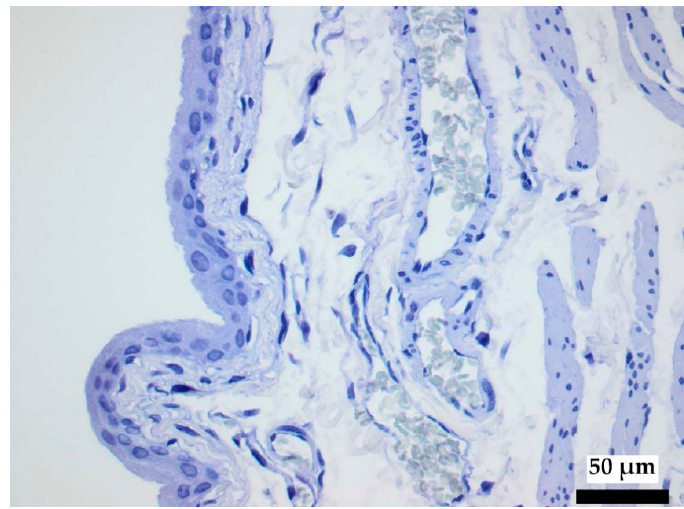
Figure 6. Rhodanine staining of urinary bladder tissue, with no evidence of copper.